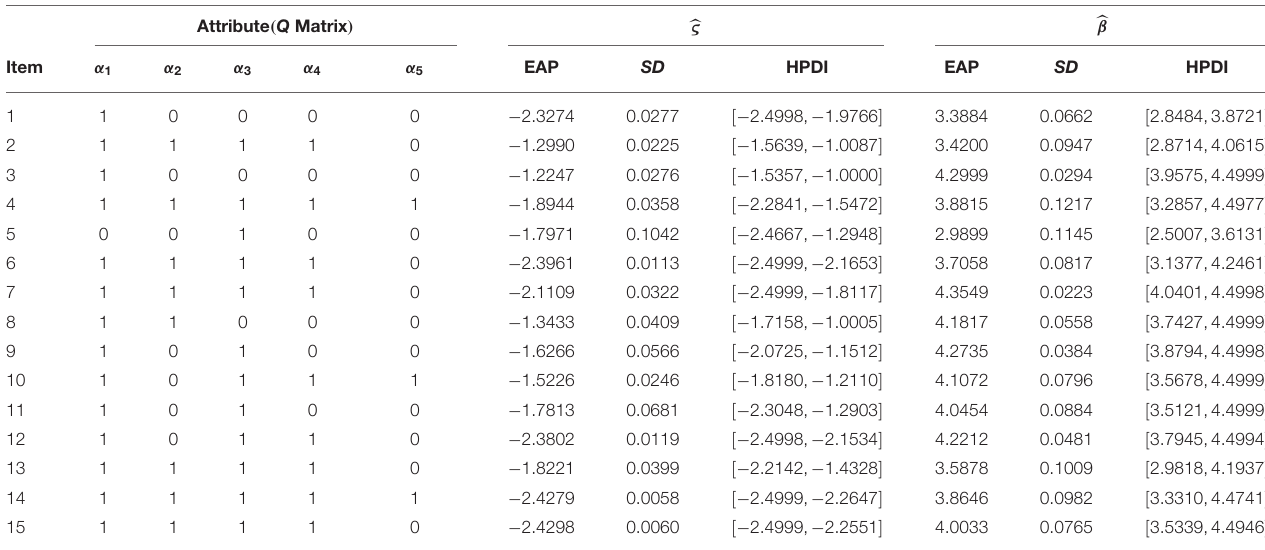
TABLE 6 | The Q matrix design and MCMC estimations of ς and β . Attribute ( Q Matrix )